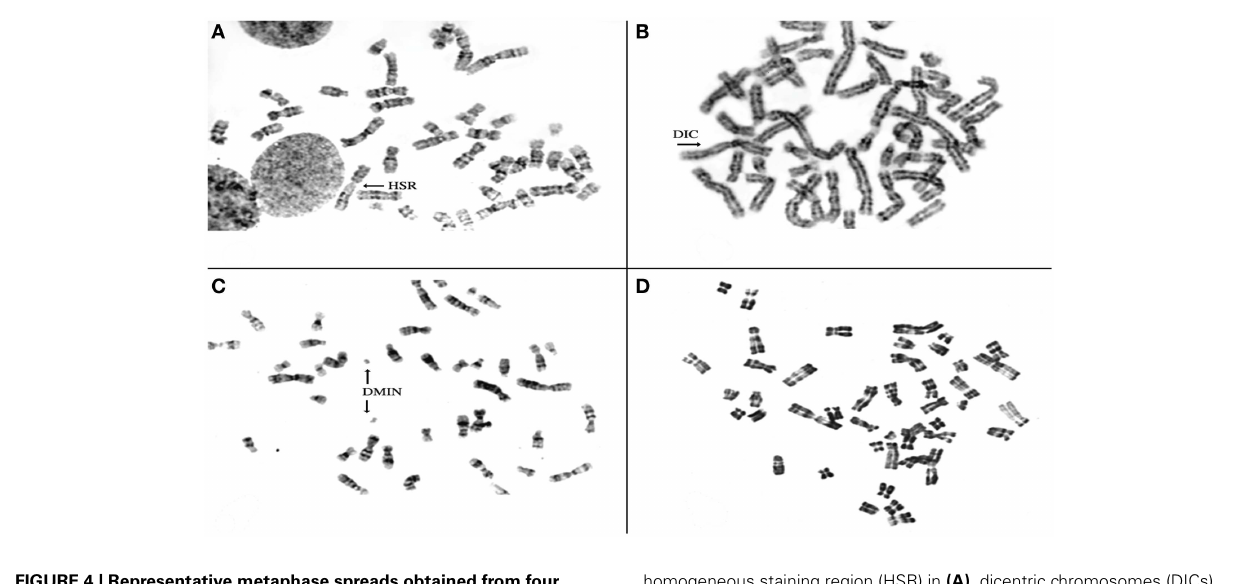
FIGURE 4 | Representative metaphase spreads obtained from four different endometriotic lesions . Note presence of structural chromosomal alterations expressed as aneuploid metaphase with